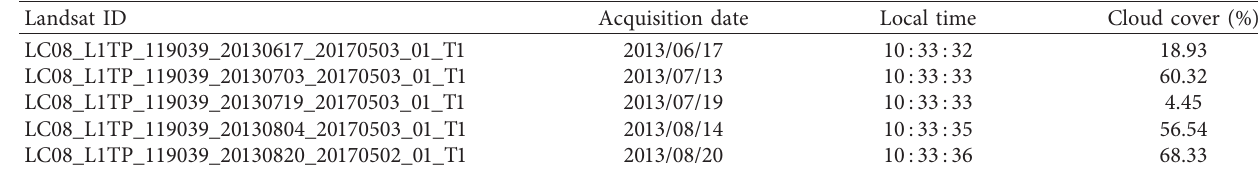
Table 1: Properties of the Landsat 8 images used in this study. Landsat ID Local time Cloud cover